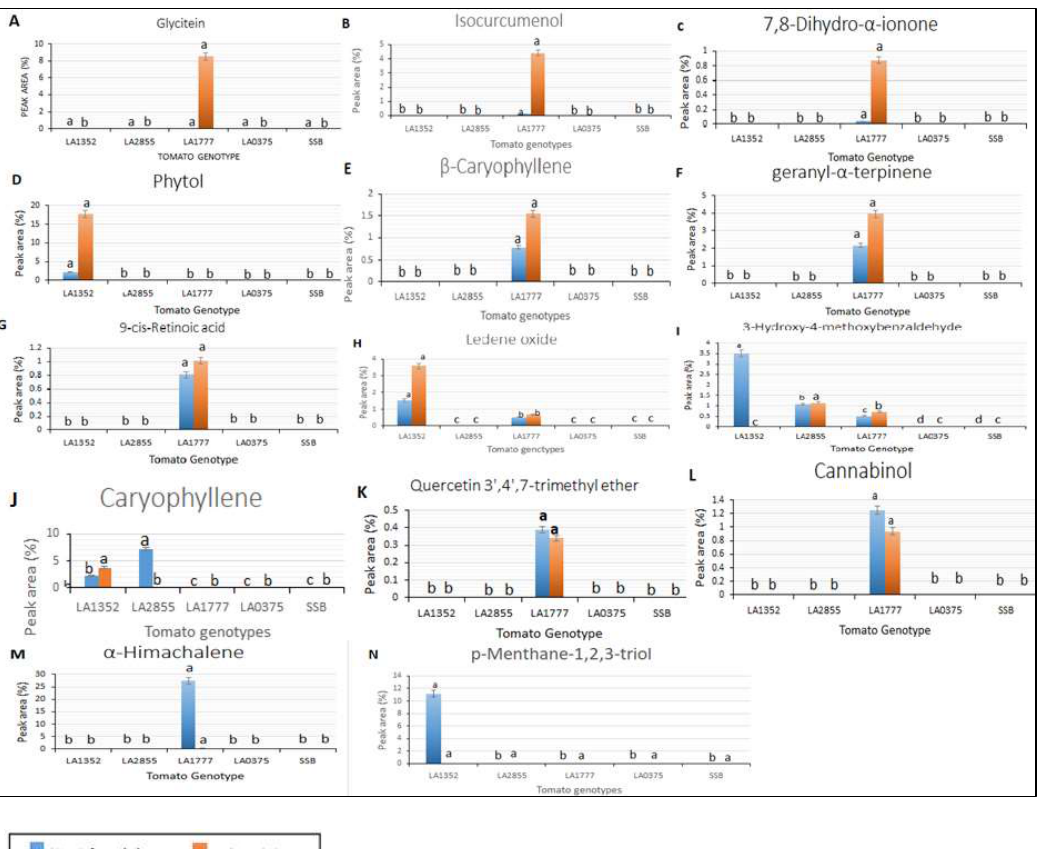
Figure 2. Peak area of volatile organic compounds detected in only resistant tomato wild species using gas chromatography/mass spectrometry. SSB—Super Stain B. The blue bar indicates the control group that was not inoculated (non-infected plants); the orange bar indicates the inoculated group (infected plants). Each compound is presented in a bar chart: ( A ) Glycitein ( B ) Isocurcumenol ( C ) 7,8-Dihydro- α -ionone ( D ) Phytol ( E ) β -Caryophyllene ( F ) geranyl- α -terpinene ( G ) 9-cis-Retinoic acid ( H ) Ledene oxide ( I ) 3-Hydroxy-4-methoxybenzaldehyde ( J ) Caryophyllene ( K ) Quercetin 3’,4’,7-trimethyl ether ( L ) Cannabinol ( M ) α-Himachalene ( N ) p-Menthane-1,2,3-triol. Results are given as mean values ± standard deviations. Values in the same bar chart with different letters are significantly different at p < 0.05.